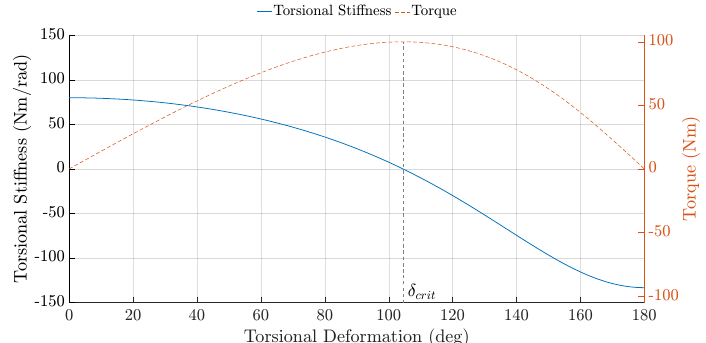
Figure 19. Torsional stiffness variation with torsional deformation for a single TRPT section of the Daisy Kite.